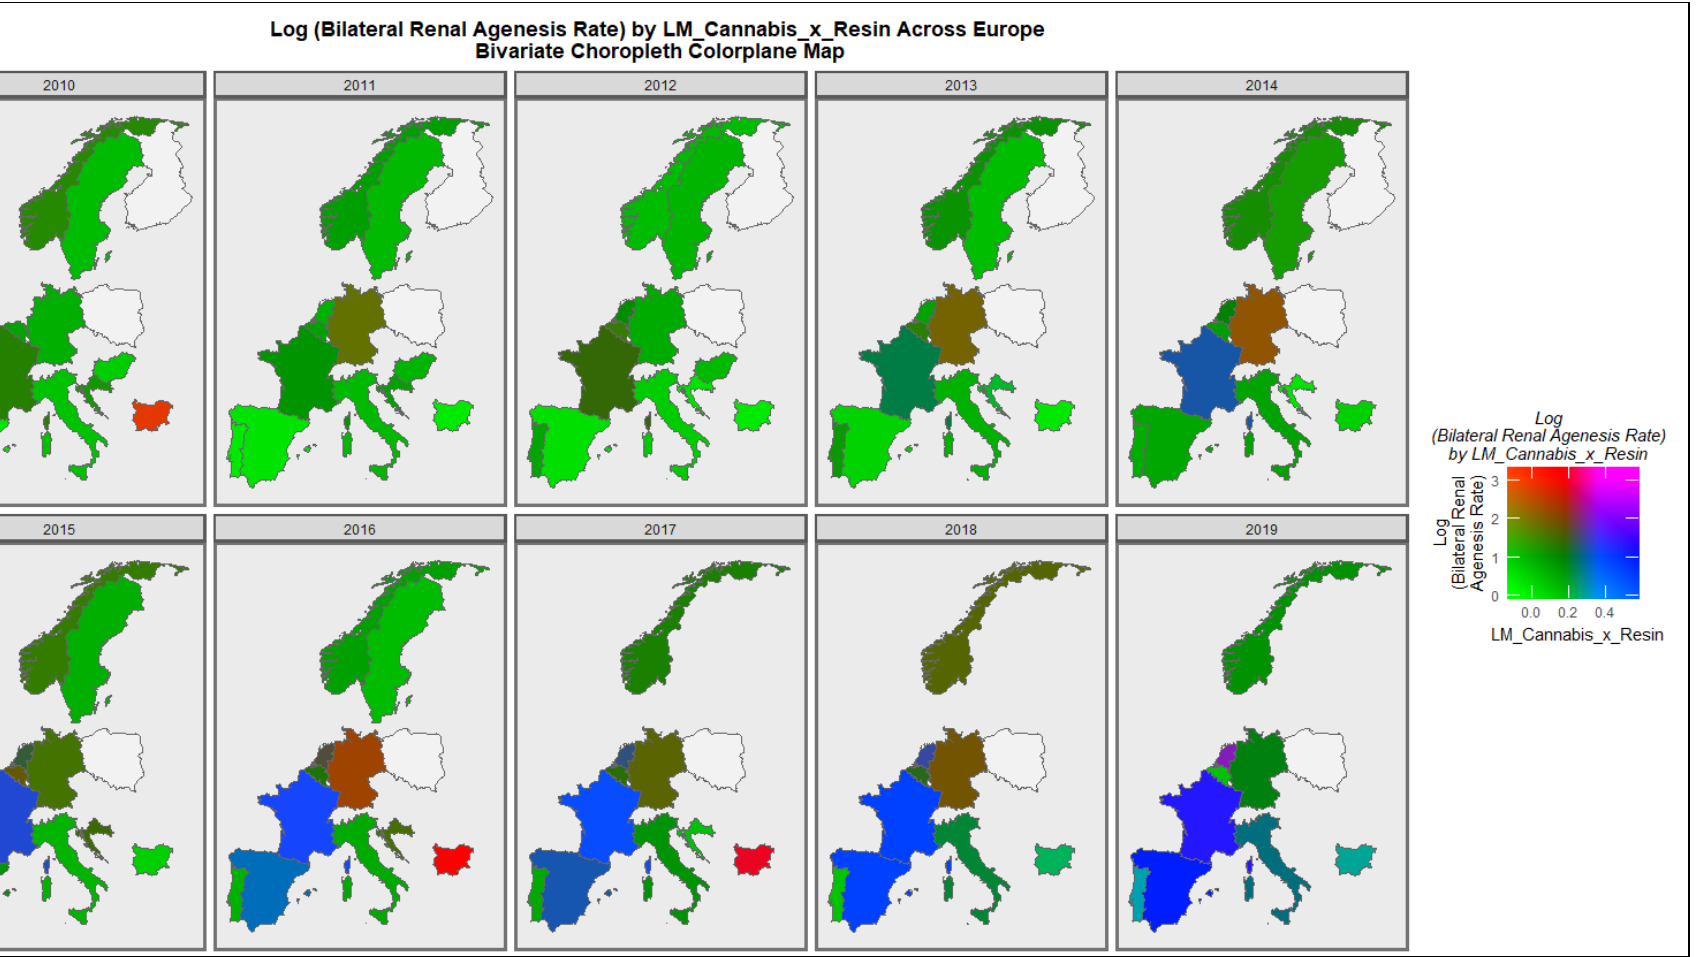
Figure 9. Colorplane bivariate time sequential map-graph of log (bilateral renal agenesis congenital anomaly rate) by last month cannabis use: cannabis resin THC concentration across surveyed European nations over time.